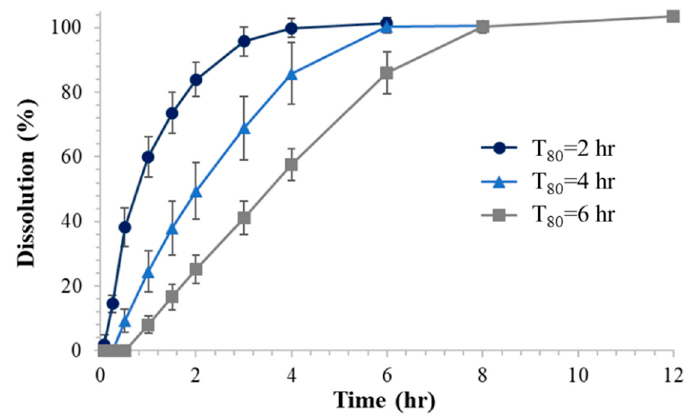
Figure 5. In vitro dissolution profiles of the optimized gastroretentive sustained release drug delivery systems with the target T 80 of 2, 4, and 6 h ( n = 3).